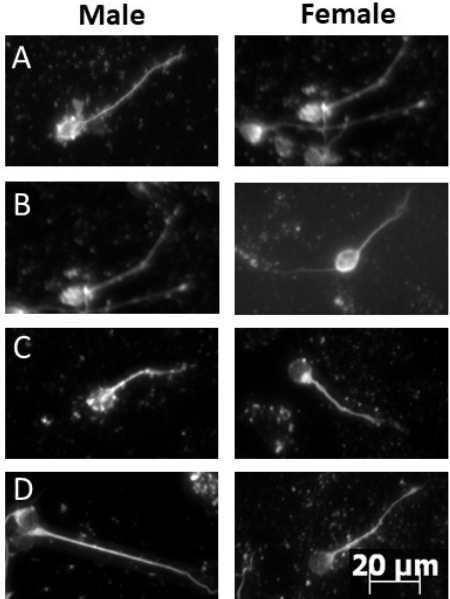
Figure 2. Hypoxia-ischemia reduced neurite outgrowth in male-derived cerebellar granule cells and this was improved by choline. Representative images of cultured cerebellar granule cells measured in neurons harvested from pups subjected to HI on PND10 (data presented in Figure 1). Representative cells from ( A ): Sham+saline males (left) and females (right); ( B ): Sham+choline males (left) and females (right); ( C ): HI+saline males (left) and females (right); ( D ): HI+choline males (left) and females (right). Cells were fixed and stained for analysis 48 h after plating.